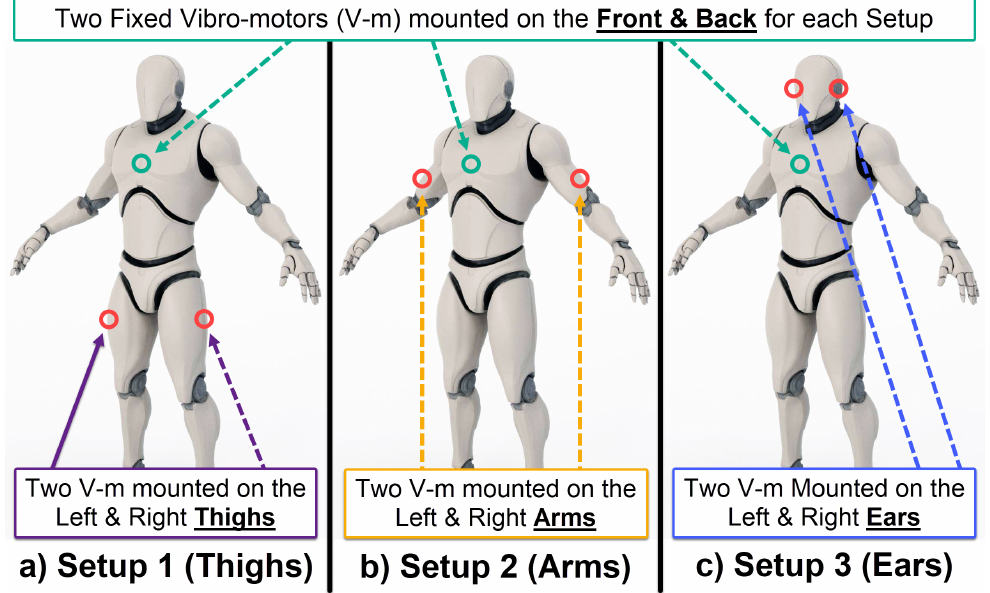
Figure 4. Suggested setups of the VR